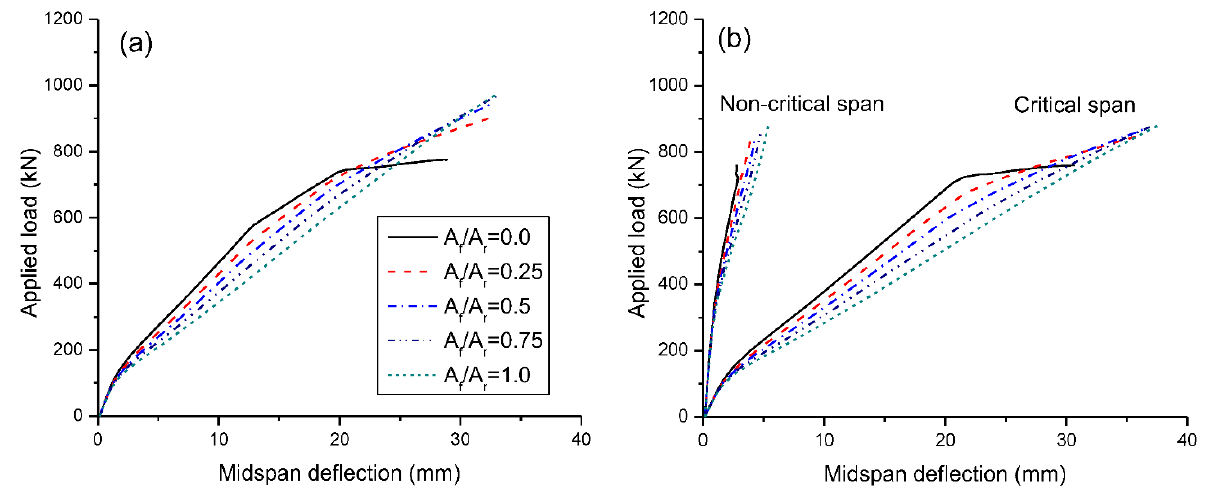
Figure 7. Load-deflection behavior: ( a ) symmetrical loading; ( b ) unsymmetrical loading.